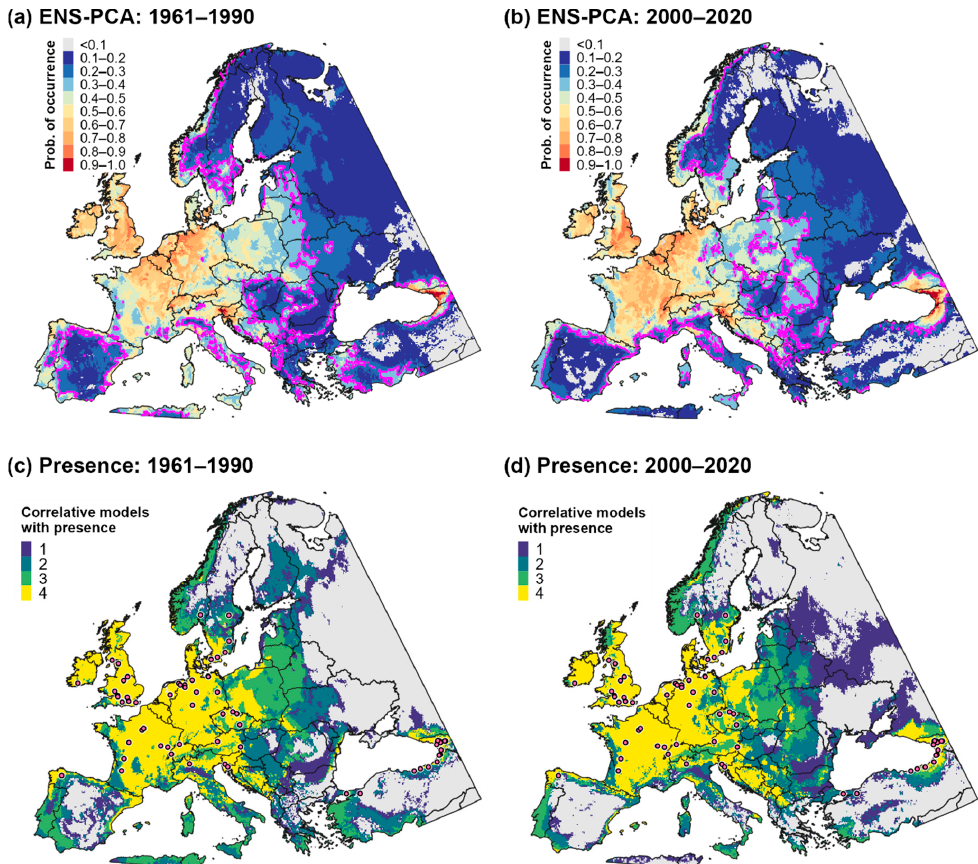
Figure 4. Maps of ( a , b ) climatic suitability and ( c , d ) presence for Calonectria pseudonaviculata in Europe based on correlative models developed using E-OBS climate data for 1961–1990 and 2000–2020 (left and right panels, respectively). Pink lines in the ensemble correlative model (ENS-PCA) delineate the threshold used to binarize models into presence–absence predictions (probability of occurrence ≥ 0.3). Maps of concordance in presence predictions produced by individual correlative models show the approximate locations of records used for fitting and testing models (pink circles).